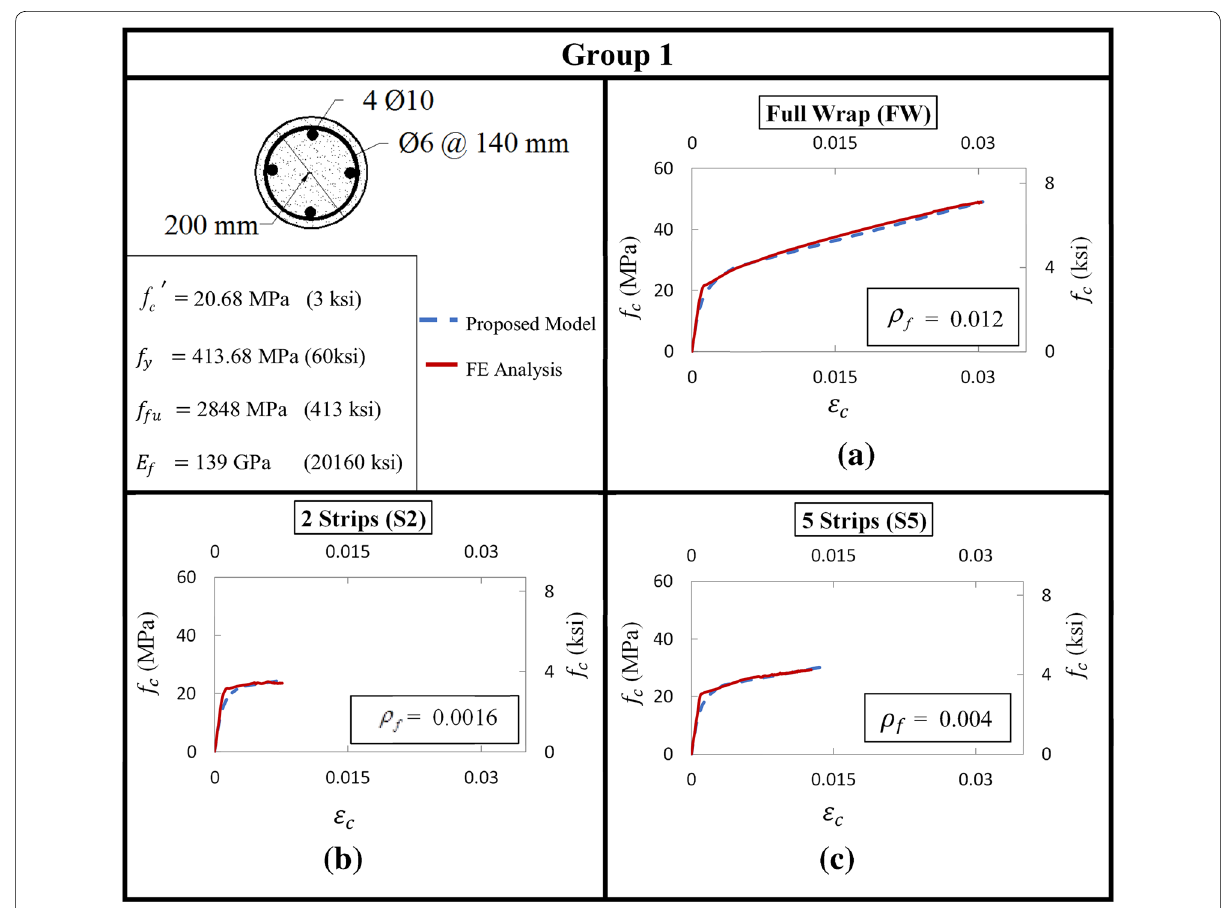
Fig. 10 Comparison between the proposed model and FE compressive ( f c ) versus axial strain (ε c ) for Group 1: a fully wrapped (FW in Fig. 2) column, b column with 2 strips (S2 in Fig. 2), and c column with 5 strips (S5 in Fig.